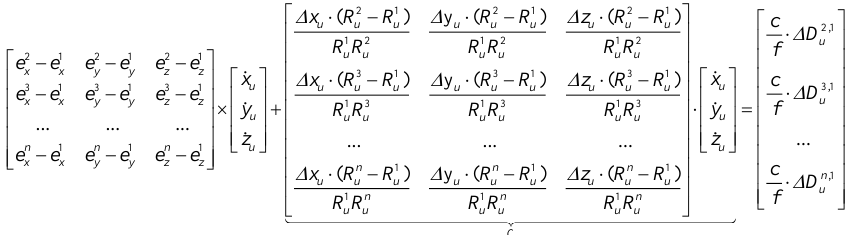
Figure 9. Geometric relationship between the transmitting antennas and receiver.